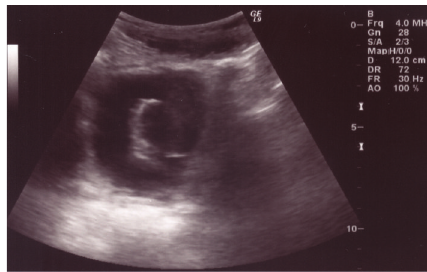
Figure 1: Preoperative US shows a mass arising from the left bladder wall of about 50 × 40 mm.